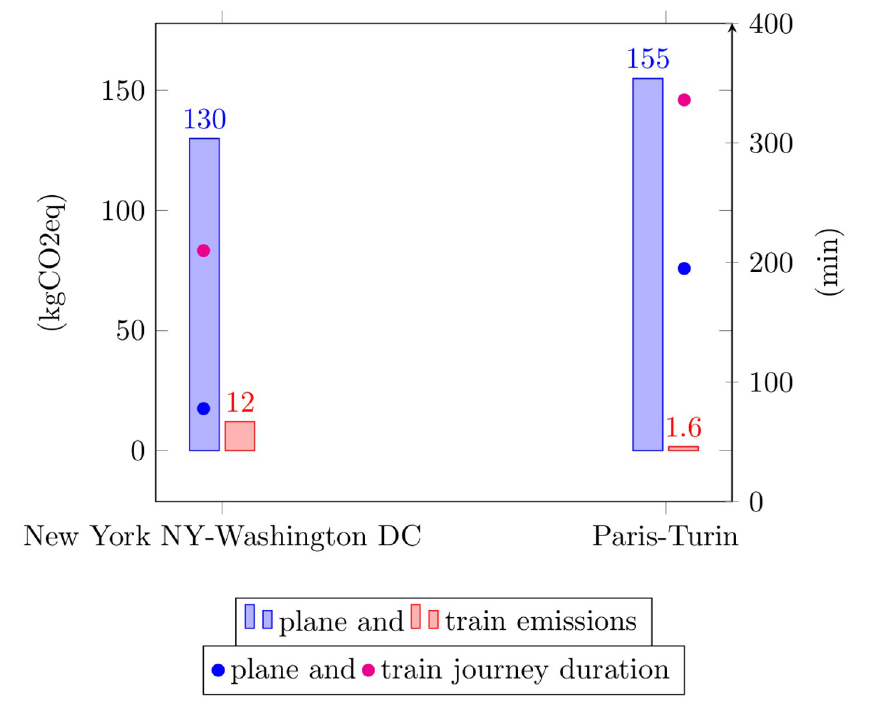
Fig 1. Comparison between plane and train travel in terms of time and CO 2 emissions (kg) for two sample itineraries. Plane emissions were calculated with the https://co2.myclimate.org/en/flight_calculators/newmyclimate flight calculator. Flight durations are estimated using https://www.expedia.fr/expedia. Train emissions and durations come from oui.sncf/SNCF for the Paris–Turin journey and from https://www.virail.frvirail for the New York, New York–Washington, DC